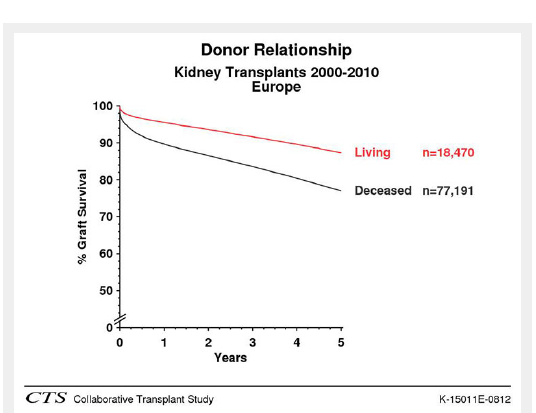
Changes in quality of life factors after successful kidney transplantation in patients previously undergoing haemodialysis. The Karnofsky Scale and the Sickness Impact Profile were used as indicators for quality of life (adapted from [46]: Jofre R, Lopez- Gomez JM, Moreno F, Sanz-Guajardo D, Valderrabano F. Changes in quality of life after renal transplantation. Am J Kidney Dis. 1998;32(1):93–100. With kind permission from Elsevier, Oxford, UK).